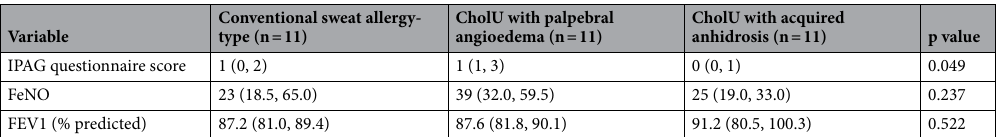
Table 2. Respiratory symptoms, FeNO, and FEV1 (% predicted value) for the 3 subtypes of CholIU. Values are shown as median (25th, 75th percentile). CholU cholinergic urticarial, FeNO exhaled nitric oxide, FEV1 forced expiratory volume in 1 s, IPAG international primary care airways